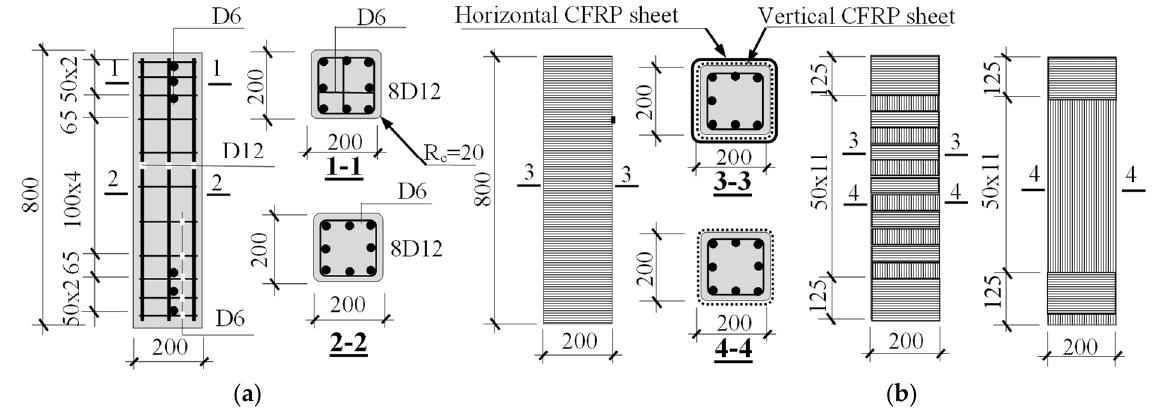
Figure 1. Detail of column specimens (in mm) ( a ) RC column; ( b ) reinforcement with FRP sheet. The experiment includes 5 controlled columns and 9 CFRP-strengthening ones. All